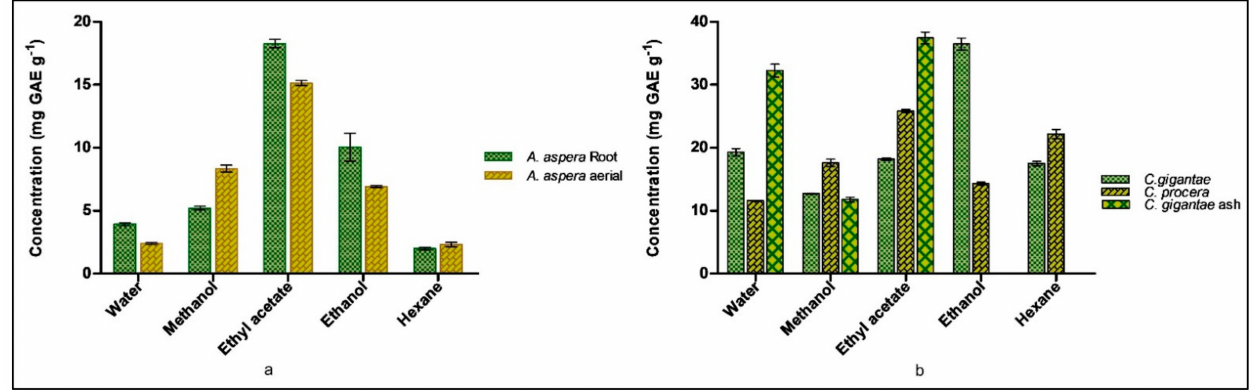
Figure 2. Total Flavonoid content determination ( a ) A. aspera ( b ) C. gigantea and C. procera .